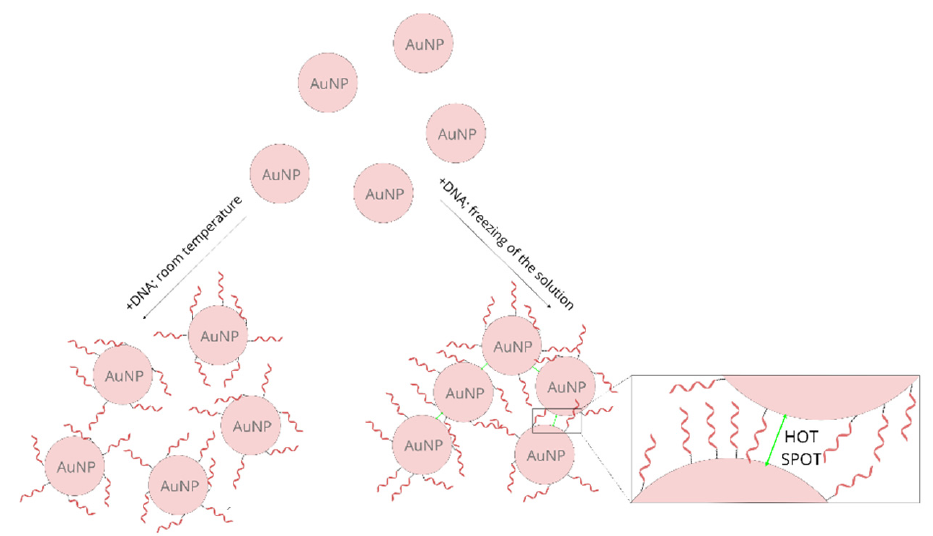
Figure 4. A scheme showing the difference between the samples prepared at room temperature and those prepared using a freezing step.